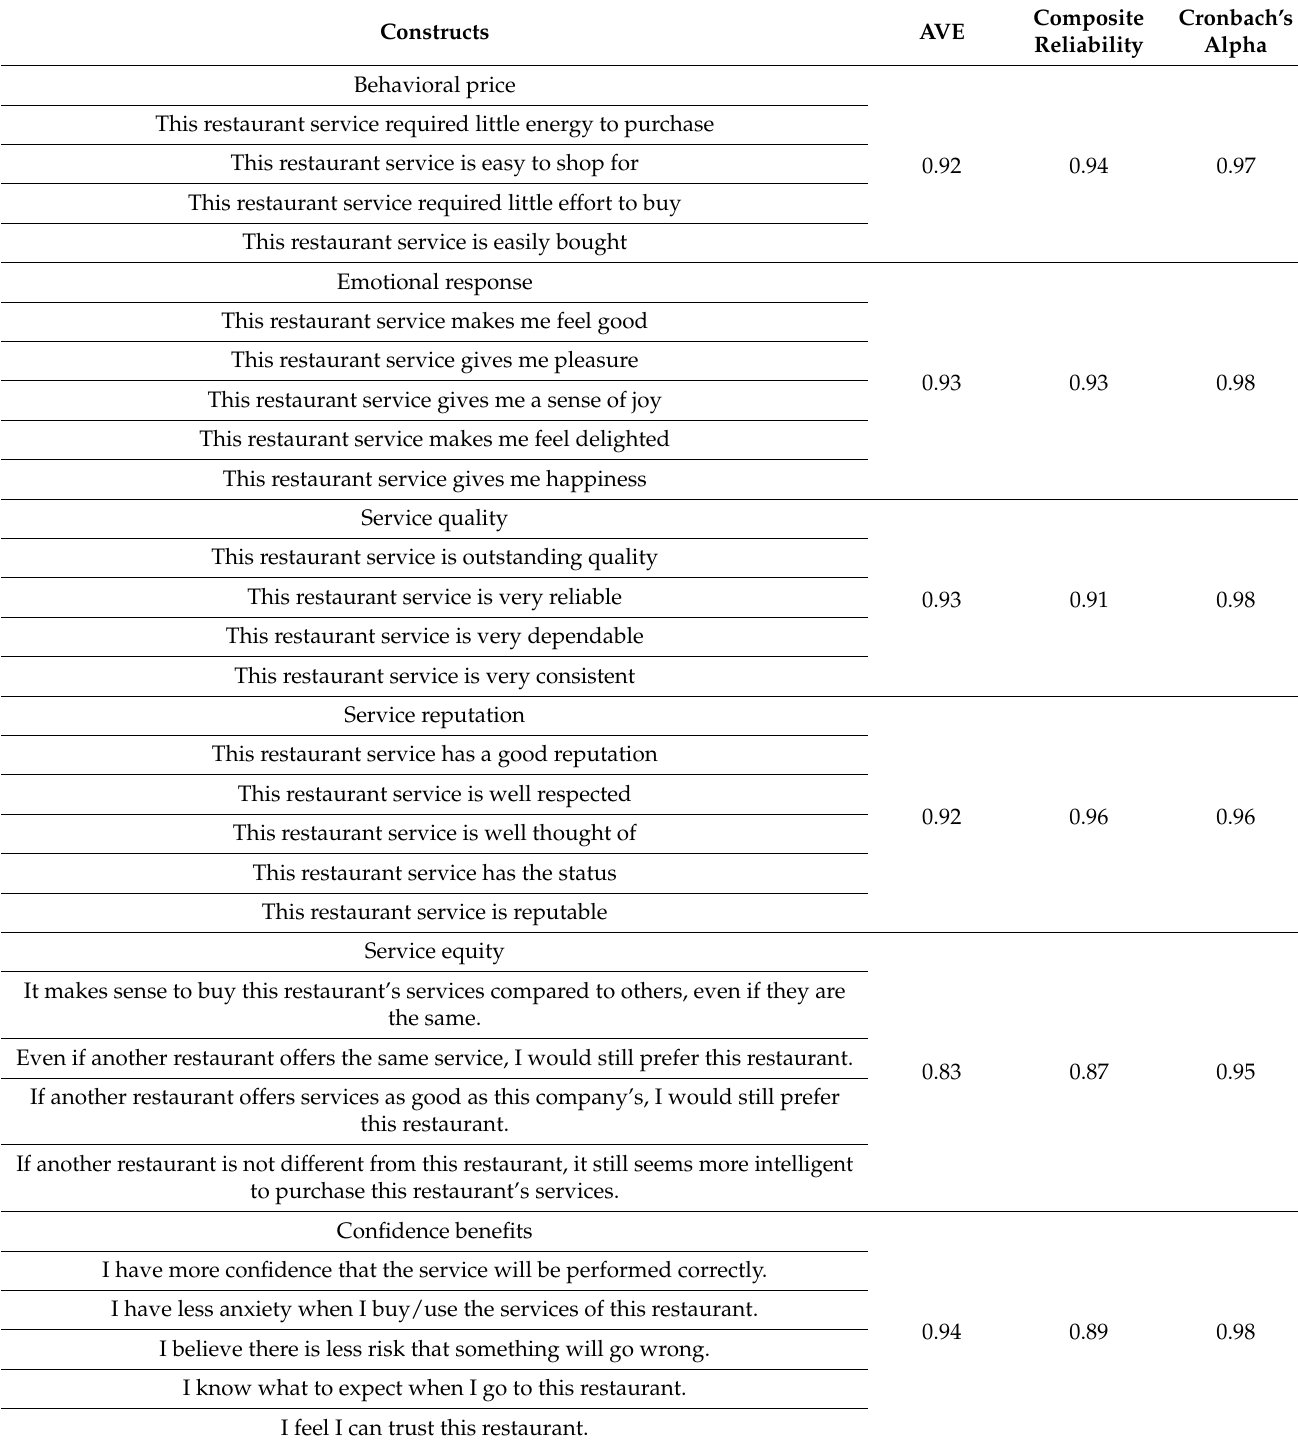
Table 2. Measuring model